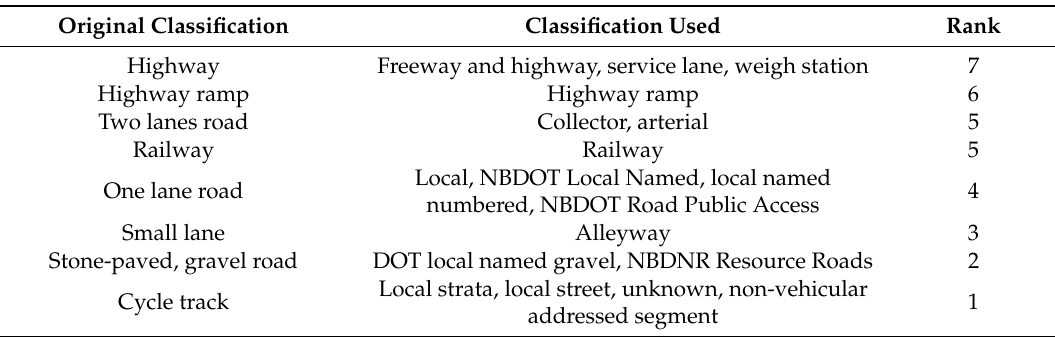
Table 4. Example of the ranking of the